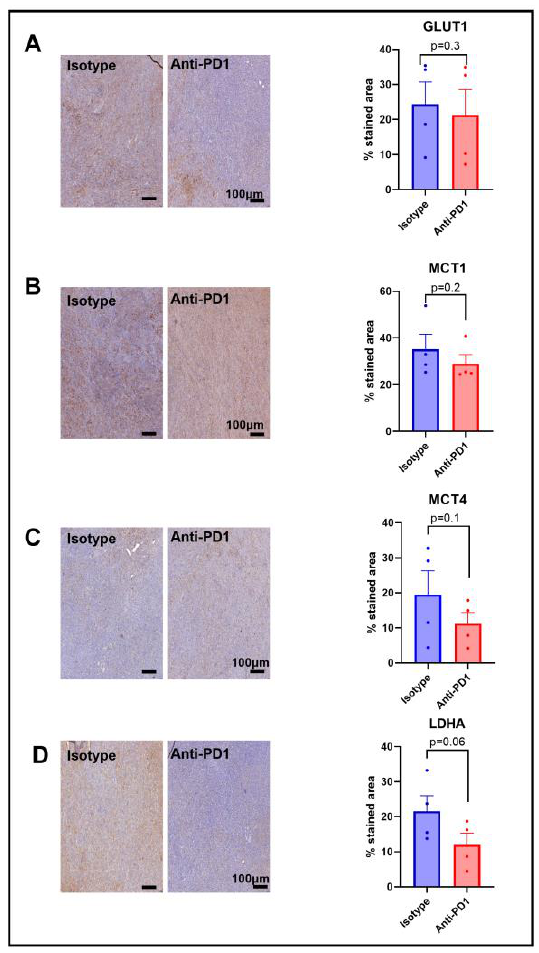
Figure 4. Expression of major glycolytic transporters and LDH-A in response to anti-PD1 in YUM- MER1.7 melanoma xenografts. IHC staining for GLUT1 ( A ), MCT1 ( B ), MCT4 ( C ), and LDHA ( D ) obtained after 1 cycle of immunotherapy (isotype control or anti-PD1). Original magnification: 20X; scale bar: 100µm. Unpaired t -test, sample size: n = 4/group. The dots correspond to the data points.